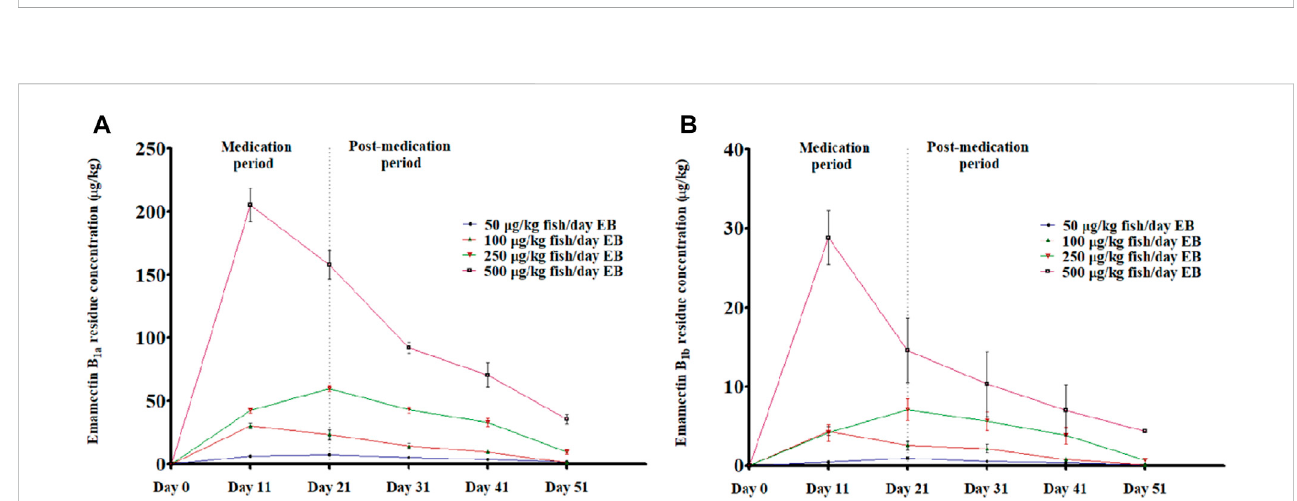
FIGURE 7 LC-MS/MS Chromatogram of Emamectin B 1a standard (A) and B 1b standard (B) .